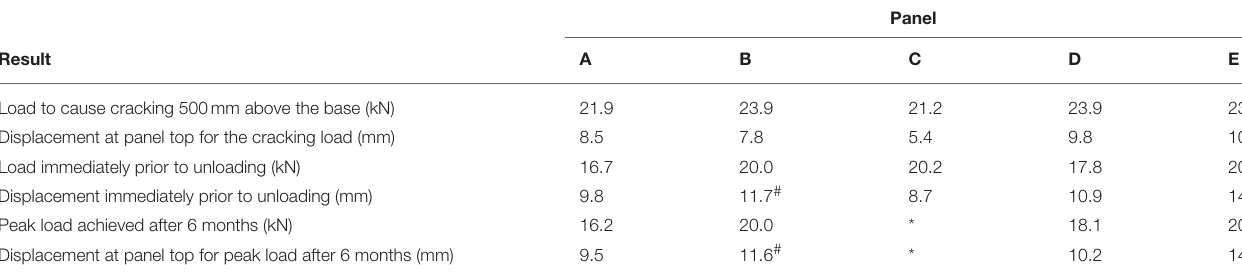
TABLE 4 | Loading-displacement comparison at various points in initial and final loading.